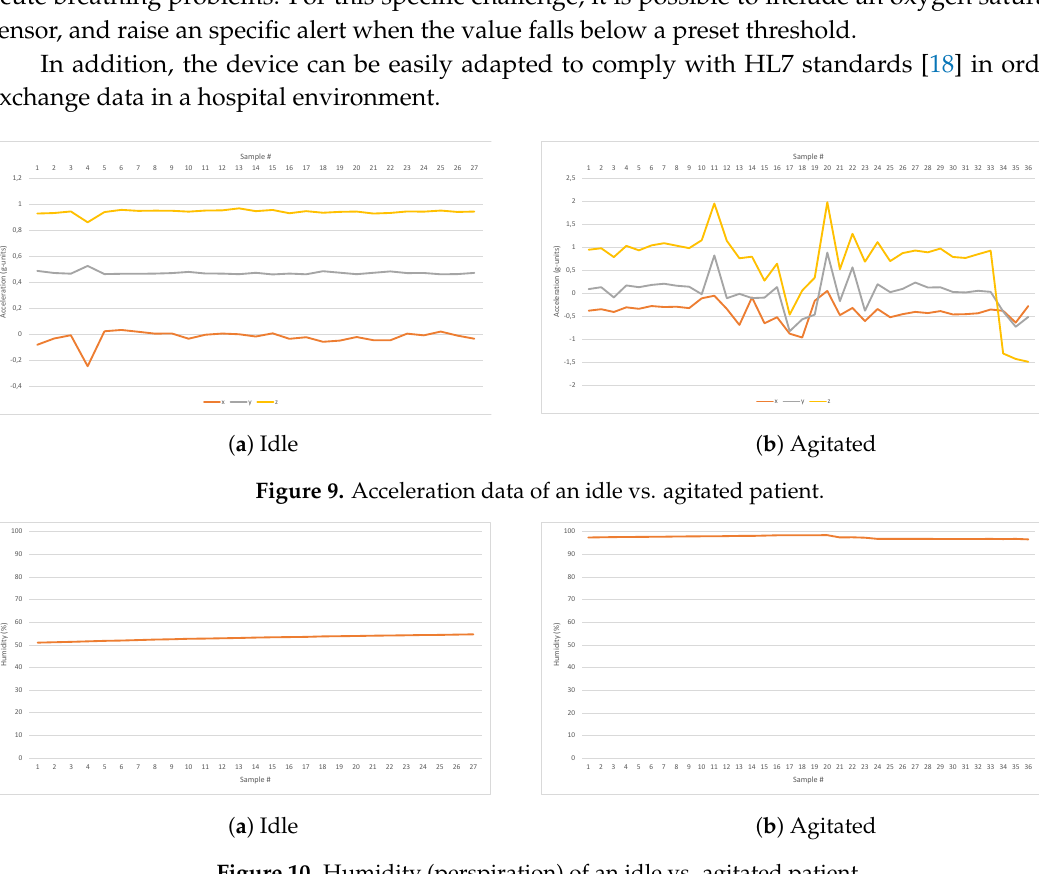
Figure 10. Humidity (perspiration) of an idle vs. agitated